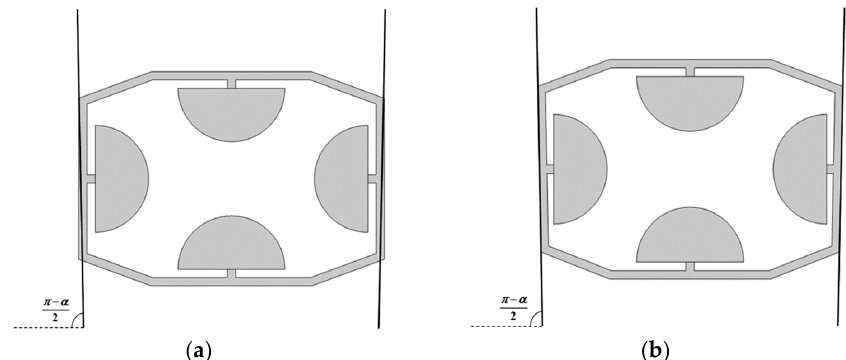
Figure 15. The structure of the cellular material: ( a ) before deformation; ( b ) after deformation.